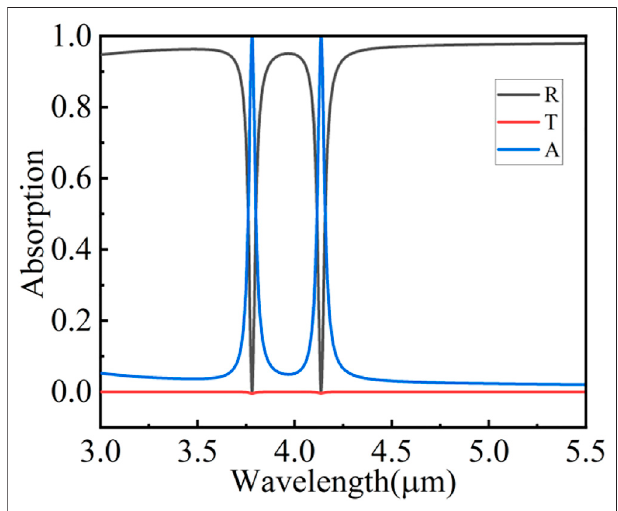
FIGURE 2 | Spectra of re fl ection (R), transmission (T) and absorption (A) under normal incidence of TM polarized